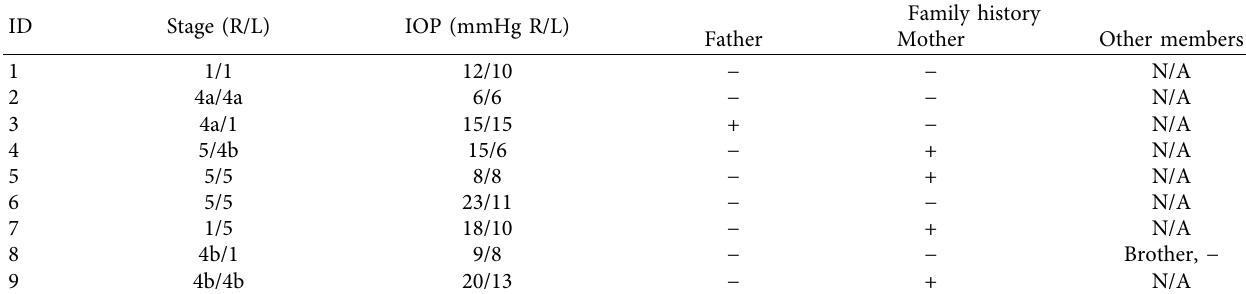
Table 2: Clinical characteristics of 9 patients and the family members’